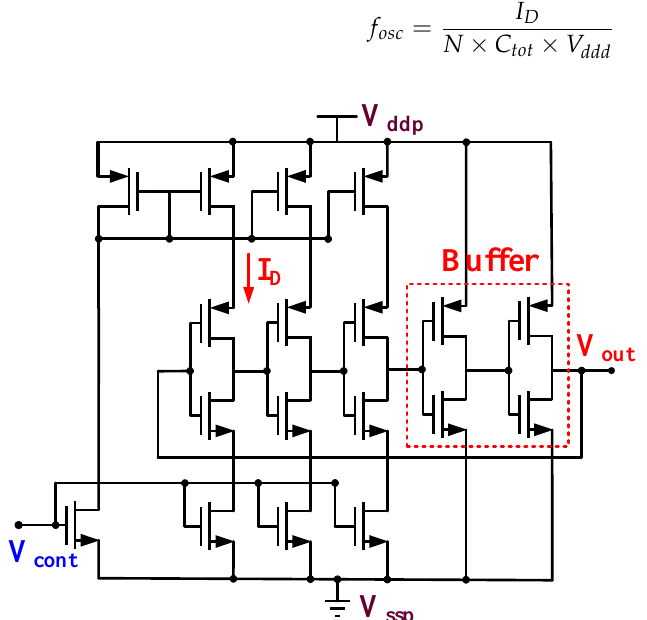
Figure 14. Modified three-stage CS-VCO with a buffer.